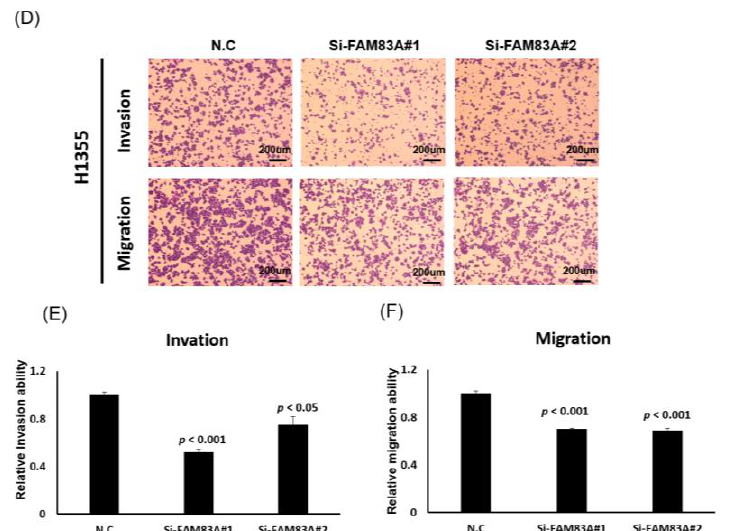
Figure 4. Suppression of lung cancer cell motility by FAM83A knockdown. ( A , B ) Cell invasion and migration in A549 cells with FAM83A knockdown. ( C ) Quantification of invading and migrating A549 cells. ( D ) Cell invasion and migration in H1355 cells with FAM83A knockdown. ( E , F ) Quantification of invading and migrating H1355 cells. N.C. indicates a random siRNA sequence control. All experiments were performed in triplicate, and the data were analyzed using Student’s t test. Differences were considered significant when p < 0.05. scale bar = 200 μm.